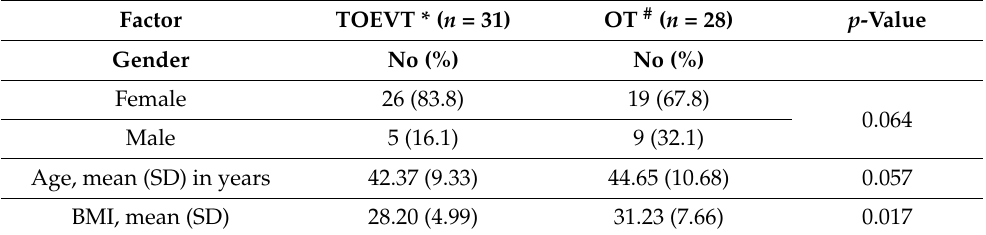
Table 1. Demographic characteristics of patients in transoral endoscopic vestibular and open thy- roidectomy groups ( n =